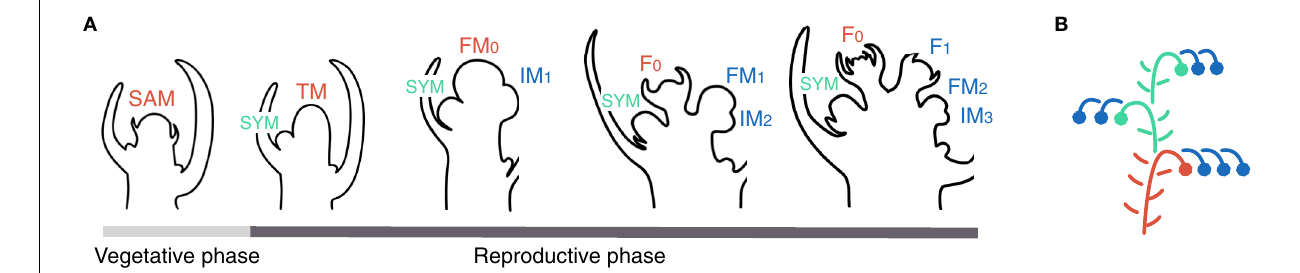
FIGURE 1 | Inflorescence development and architecture in tomato. (A) Successive steps of inflorescence development. The vegetative shoot apical meristem (SAM) initiates vegetative phytomers made up of an internode, a leaf and an axillary meristem. When entering floral transition, the SAM takes an intermediate, transitional meristem (TM) fate whereas the last vegetative axillary meristem called the sympodial (SYM) takes over shoot growth. The TM initiates a new phytomer with